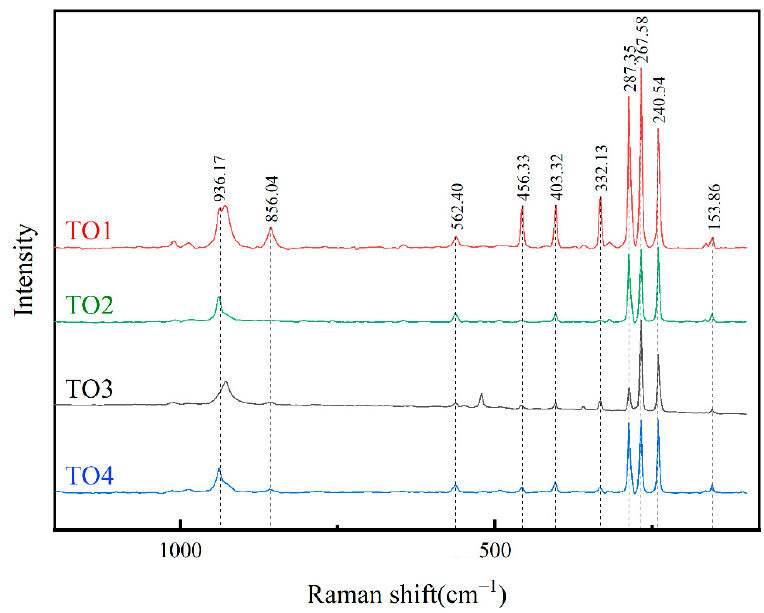
Figure 8. Raman spectra of inclusions of TO10 samples.